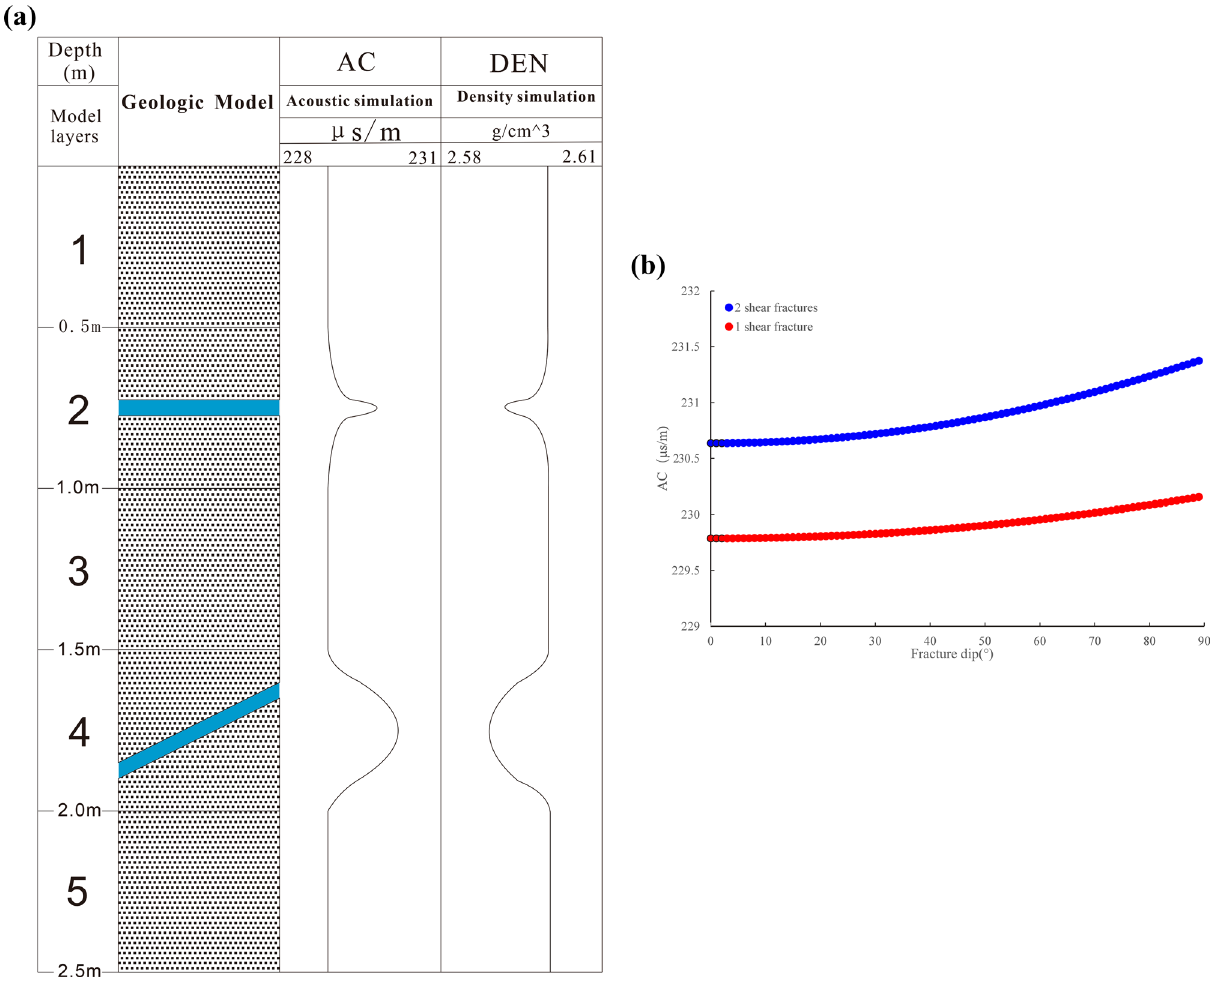
Figure 4. A geological model and response characteristics. (a) A geological model with five layers of tight quartz sandstone from top to bottom and physical models of two fractures, the fracture dip of the second layer is 0°, and the fracture dip of the fourth layer is 30°. (b) The response characteristics of the acoustic time difference of one and two fractures in the tight quartz sandstone with a fracture dip